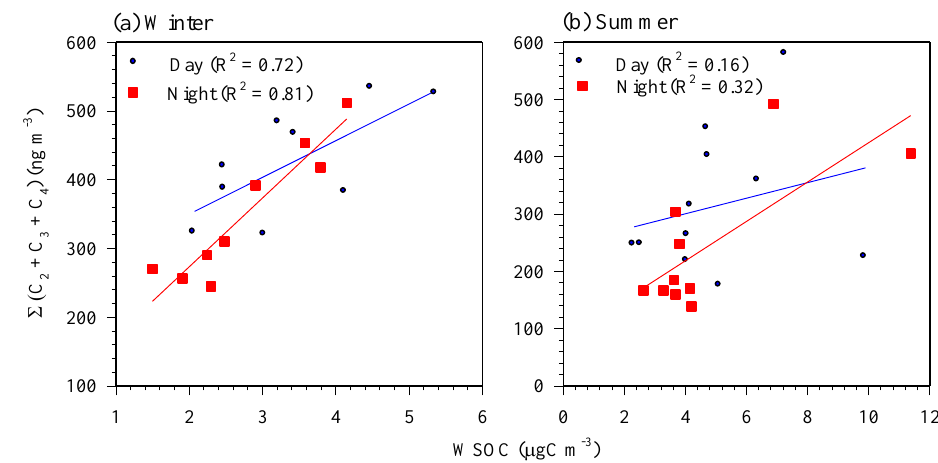
Fig. 10. Relation between water-soluble organic carbon (WSOC) and total C 2 -C 4 diacid concentrations during (a) winter and (b) summer